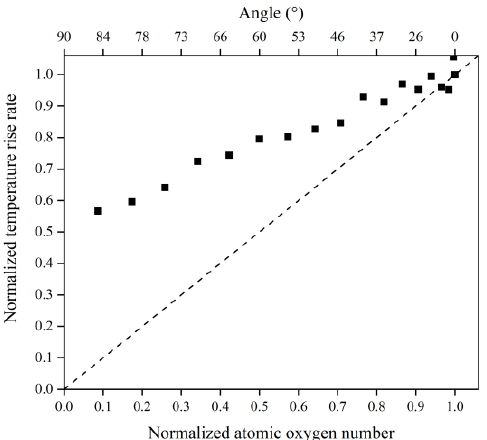
Figure 18. Normalized temperature rise rate of the Kapton under different amounts (incidence an- gles) of atomic oxygen impact.